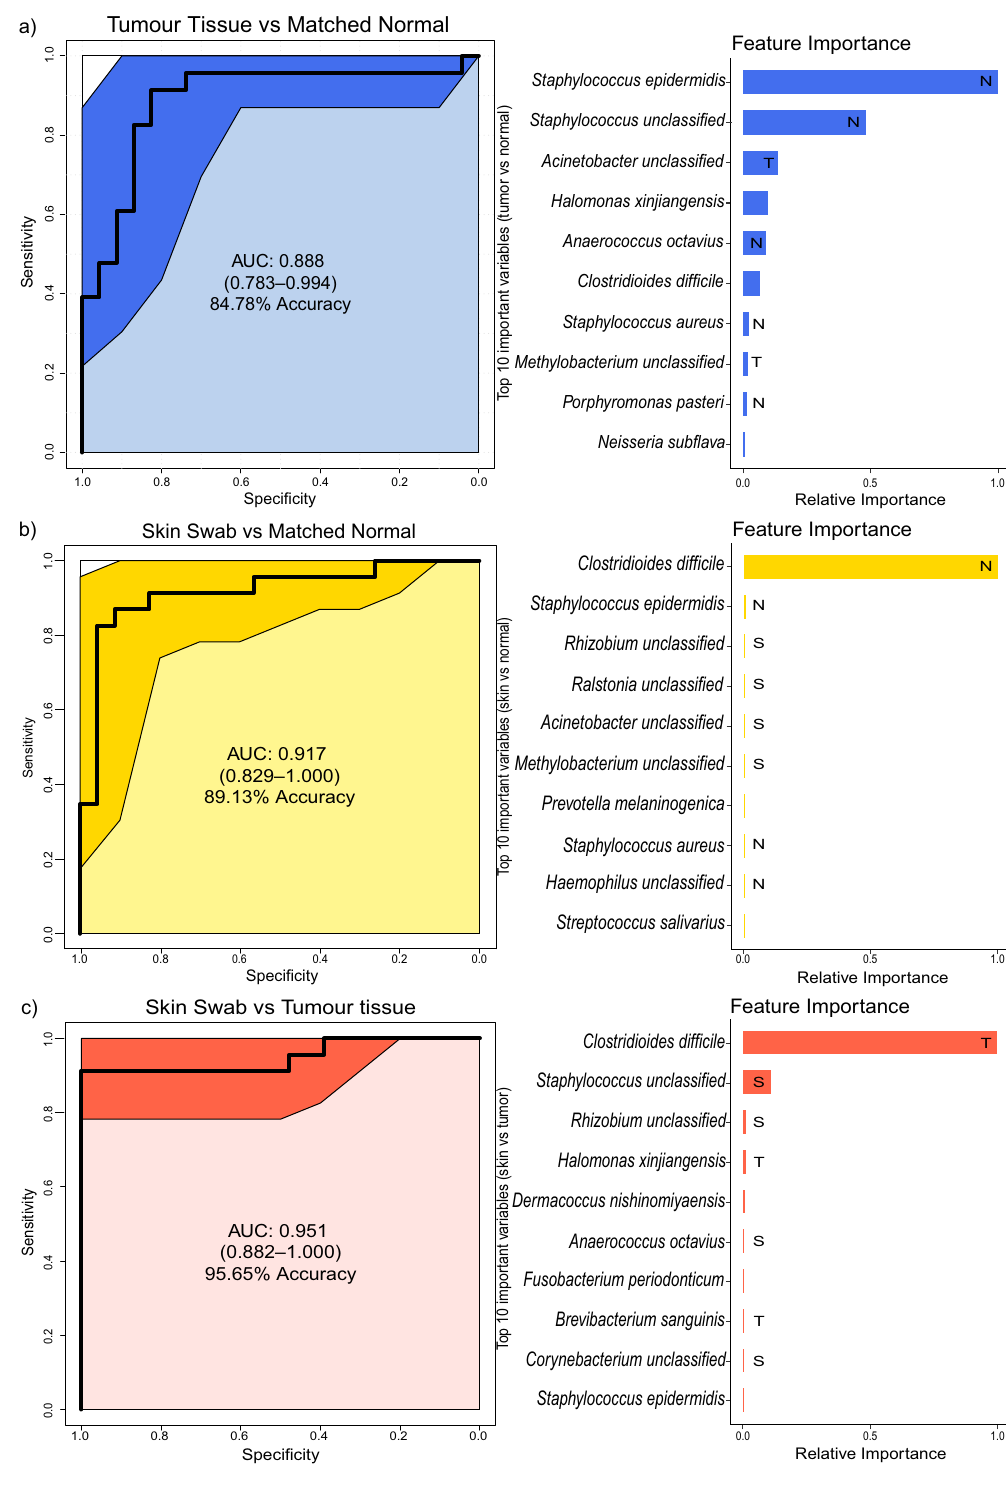
Figure 4. Pairwise machine learning classification of breast cancer patient specimens. Receiver operating characteristic curves (ROC) for the boosted tree models based on species abundance with proportional normalisation on species present in at least 5% of samples. Illustrated are comparisons of: ( a) tumour and matched normal tissue, ( b) skin swabs and matched normal tissue, and ( c) skin swabs and tumour tissue. A model with an area under the curve (AUC) of 0.5 has no discriminatory capacity, whereas an AUC of 1 indicates perfect separation of the response variables. The solid black line tracks the consensus AUC, while the surrounding, shaded area defines the 95% confidence interval. Beside each ROC curve, feature importance plots show the relative importance for the 10 taxa with the highest gain, normalised by the frequency a particular taxon is chosen for a model, for each comparison alongside their highest known classification. The labels within the bars indicate the sample type in which the respective taxa are significantly increased. Bars without labels indicate that the respective taxon is not differentially abundant in any sample